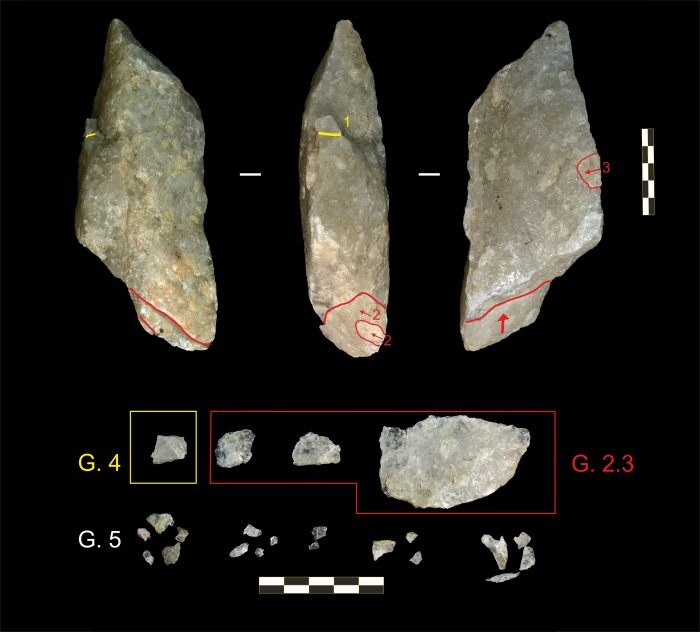
Percussive positives and refit from active element O11.See description of groups in Table 3 caption. All positives from Group 5 were detached during four separate nut cracking sessions. First, the positive from Group 4 (1), located on the left lateral side of the plane, was detached. This was followed by the two positives from Group 2.3 that conjoined on a dorsal-ventral refit located on the proximal plane (2). The last positive of the sequence is the fragment from Group 2.3 located on the right side of the horizontal plane (3), which was detached in a different experimental session.